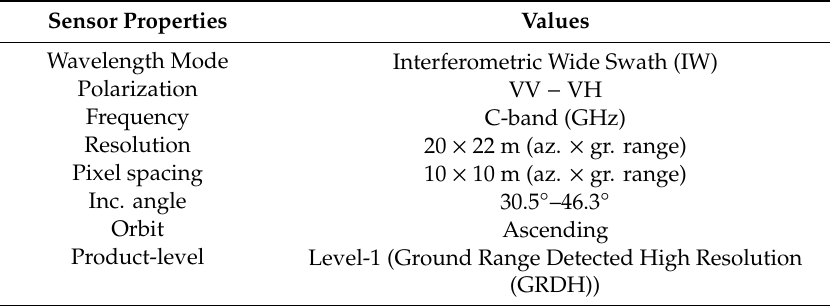
Table 3. Characteristics of the S-1 data